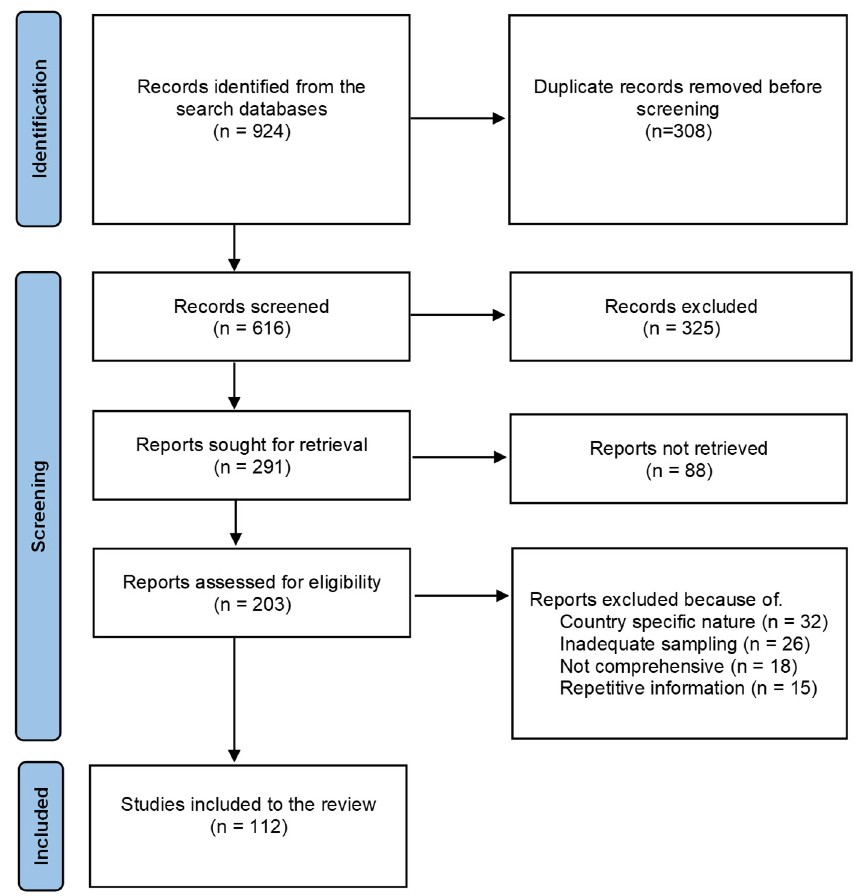
Figure 1. Schematic diagram of the systematic review process.